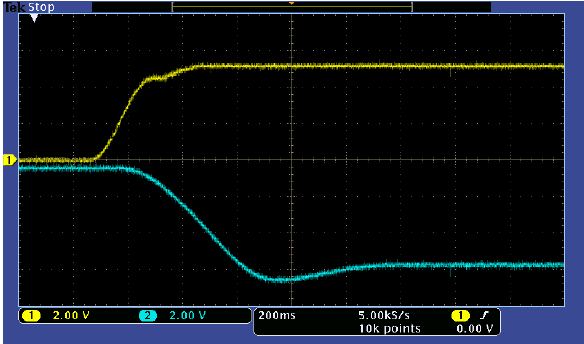
Figure 14. Reverse position tracking.